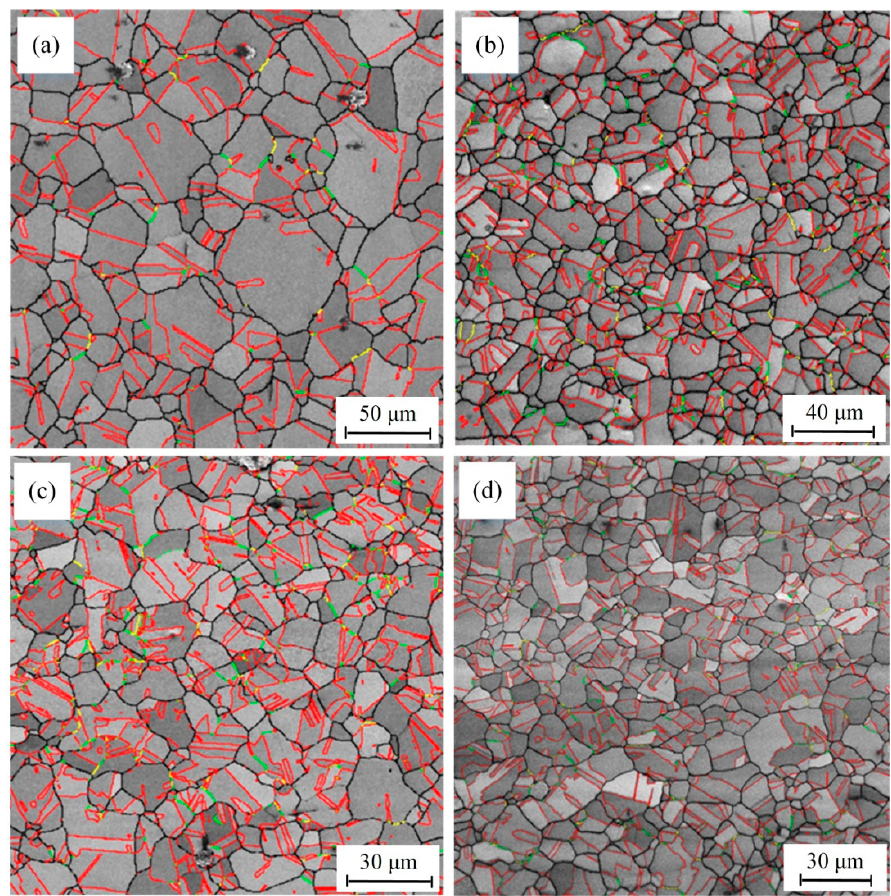
Figure 2. EBSD-Image Quality maps for the microstructure of the tested steel with different rolling schedule in SHR process.( a ) S-p3-70%, ( b ) S-p5-90%, ( c ) S-p7-90% and ( d ) S-p10-90%. Red line indicate the anealing twin boundary, black line indicate the large angle grain boundary, green line indicate the Σ 9 grain boundary, yellow line indicate the Σ 27 grain boundary.